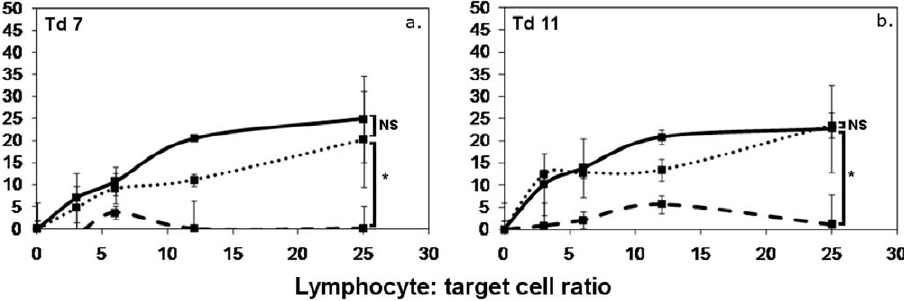
Figure 5. ADCC responses of nylon wool non adherent cells from naive devils against K562 cells. 51 Cr release assays were performed for 18 hr at lymphocyte: target ratios of 25:1, 12:1, 6:1 and 3:1, in the presence or absence of K562 immune serum. Solid black lines represent the responses of MNC in the presence of immune serum. Dashed lines represent levels of cytotoxicity in naive MNC without serum. Dotted lines represent the responses of nylon wool non adherent cells in the presence of immune serum. In the presence of immune serum, there was no statistically significant difference between the responses of MNC and nylon wool non adherent cells. The responses of nylon wool non adherent cells in the presence of immunised serum were significantly greater than samples without immune serum (F test; * p ,